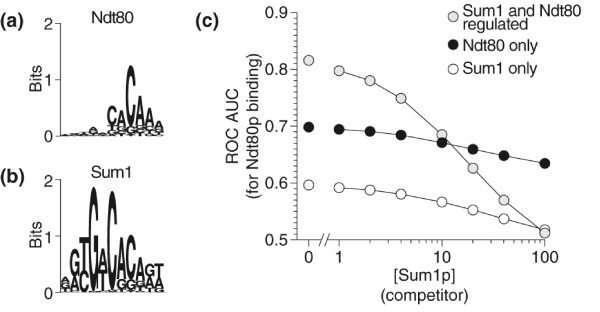
Effect of competition by Sum1p on predicted binding by Ndt80p. Sequence logos [37] for (a) Ndt80p and (b) Sum1p binding specificity. (c) Values for the area under the receiver operating characteristic curve (ROC AUC) quantify how well predicted Ndt80 binding distinguishes regulated genes from non-regulated genes. The regulated gene sets are the genes controlled by Ndt80 only (black), Sum1 only (white), or both (gray). For all comparisons, the set of non-regulated genes consists of genes not regulated by Ndt80 or by Sum1. Sum1p concentration is expressed as a ratio to the optimal predicted Kd value for Sum1p binding; Ndt80p concentration is set equal to the optimal predicted Kd value for Ndt80p binding. The regulatory region was defined by the uniform weight function over the sequence between 600 base pairs 5' to the open reading frame and the start of translation.